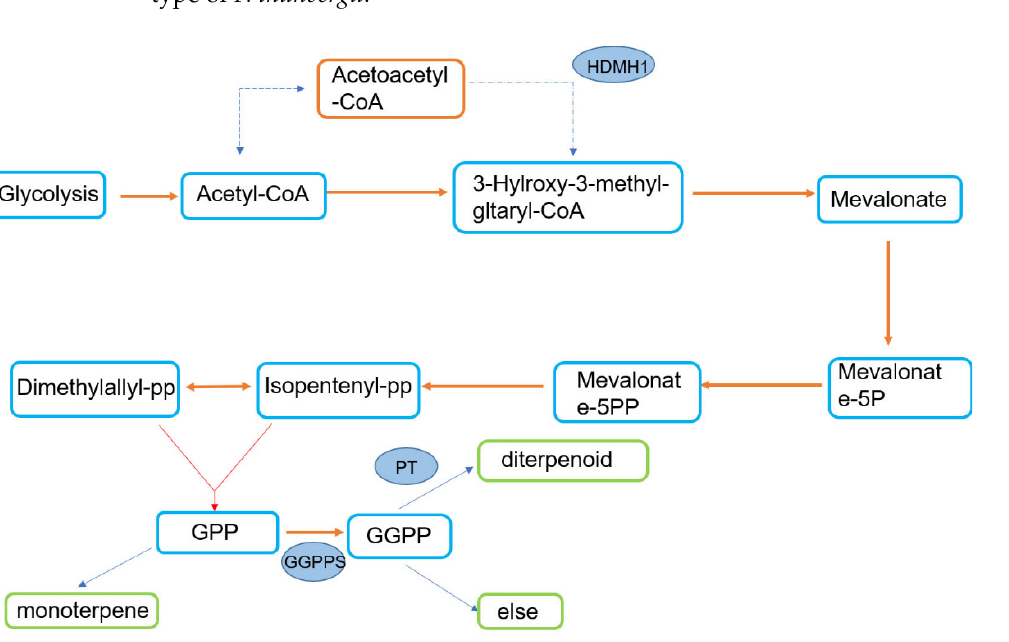
Figure 4. Terpene synthesis pathway.